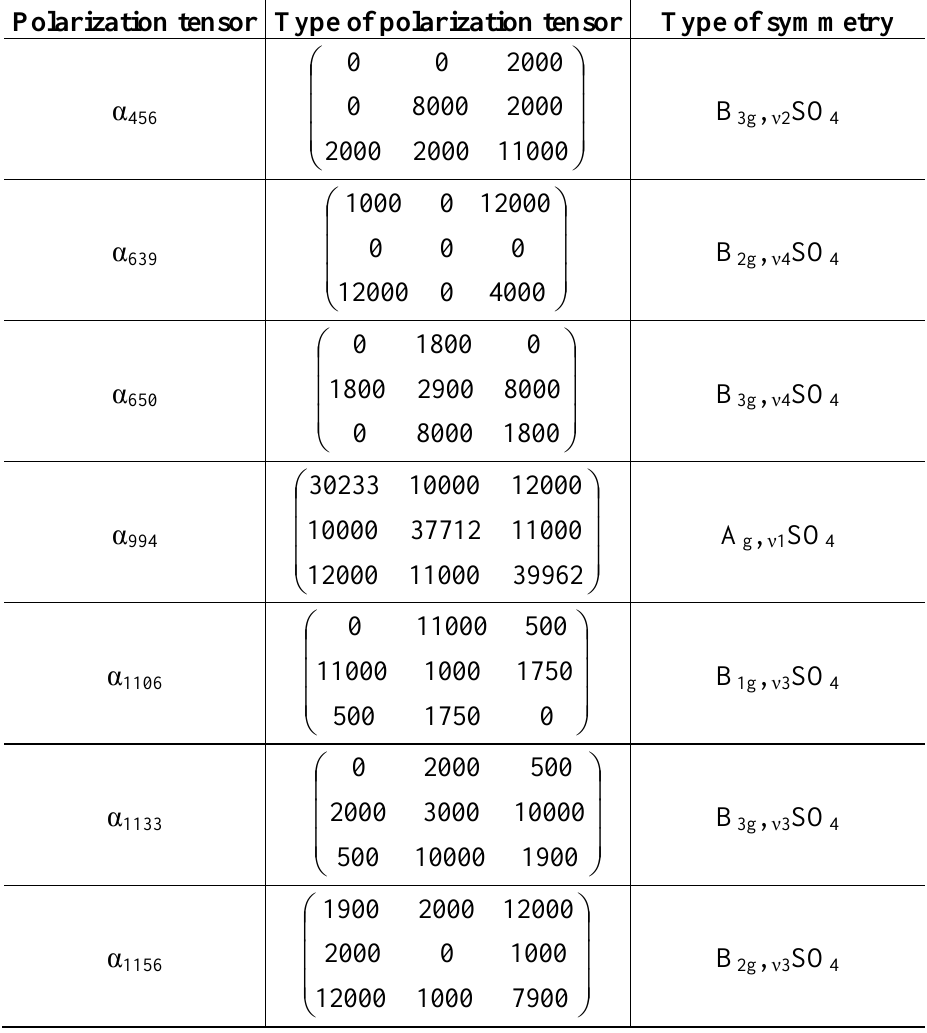
Table 4. Components of a polarization